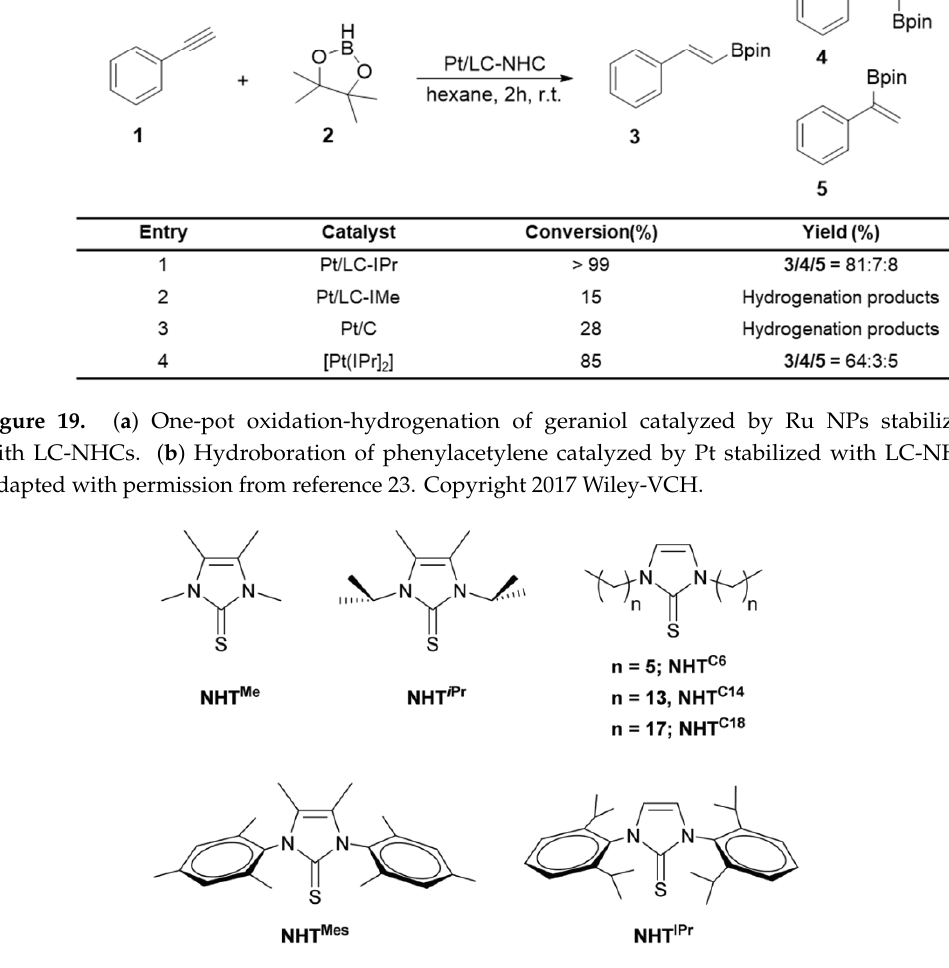
Figure 20. N ‐ Heterocyclic thiones used in reference 24 by Moraes et al . Reproduced with permission from reference 24. Copyright 2020 The Royal Society of Chemistry.